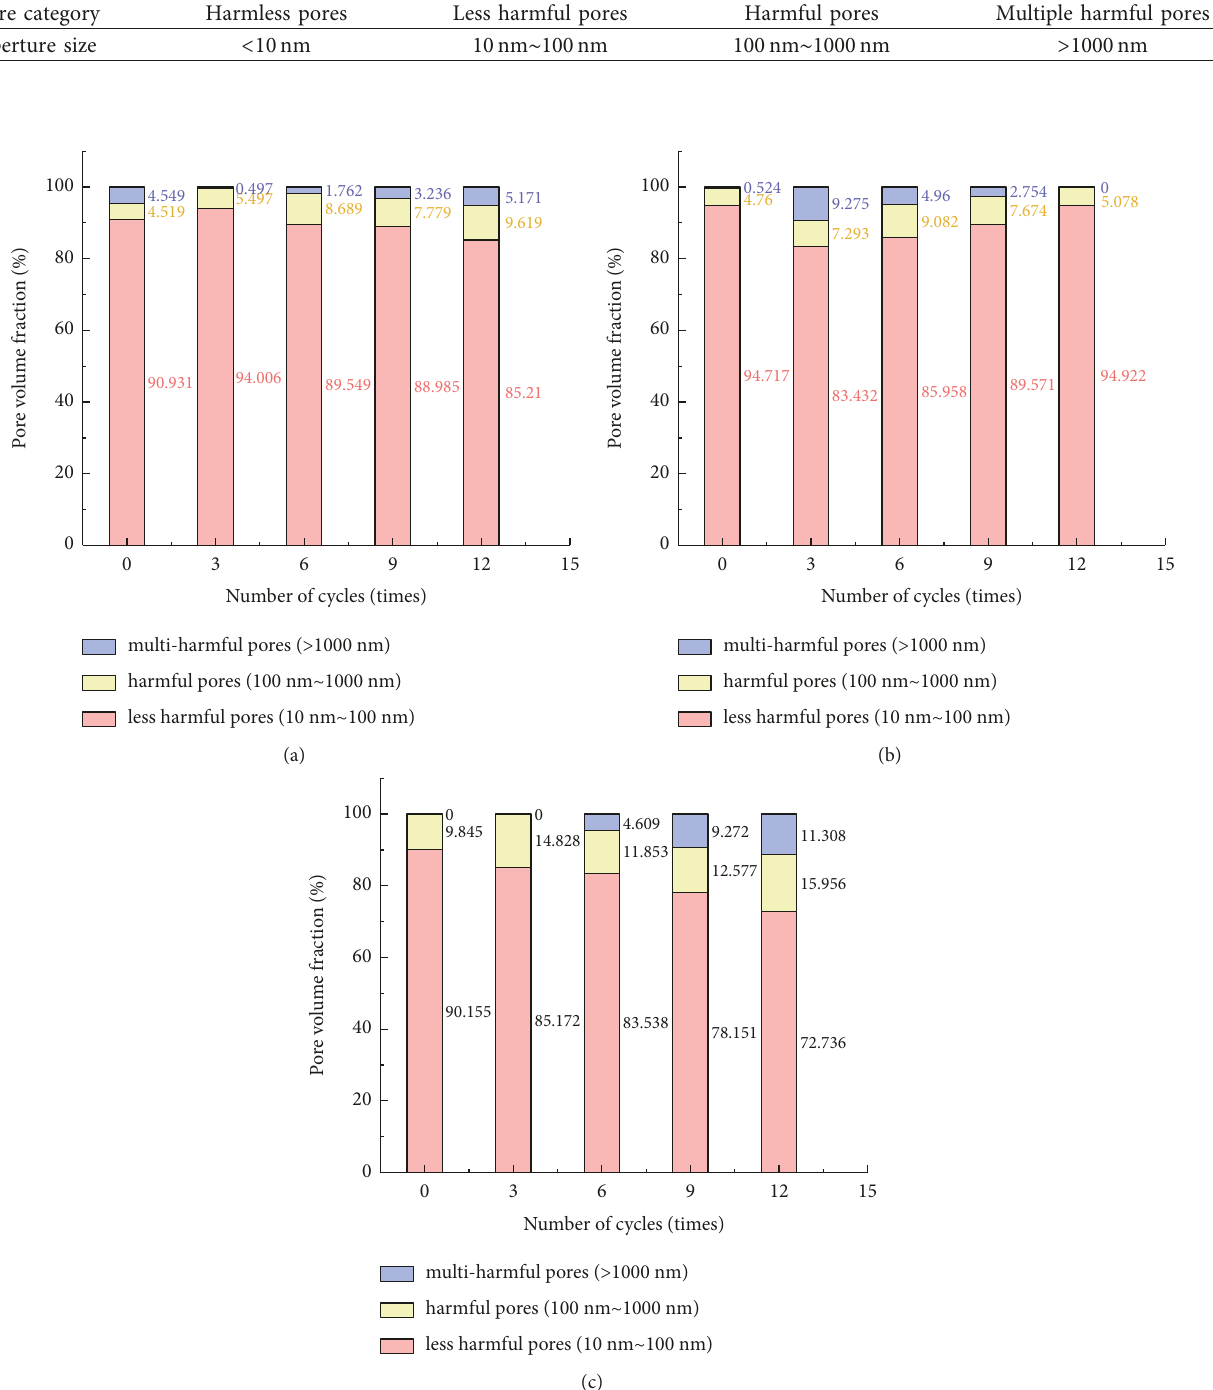
Figure 10: Pore volume fraction distribution of semirigid base material under different cycle times. (a) 20 ° C ∼ 60 ° C. (b) (c) 20 ° C ∼ 20 ° −